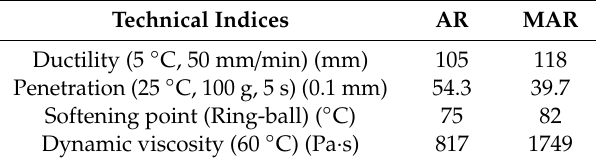
Table 3. Main technical indices of rubberized asphalt (AR) and modified AR